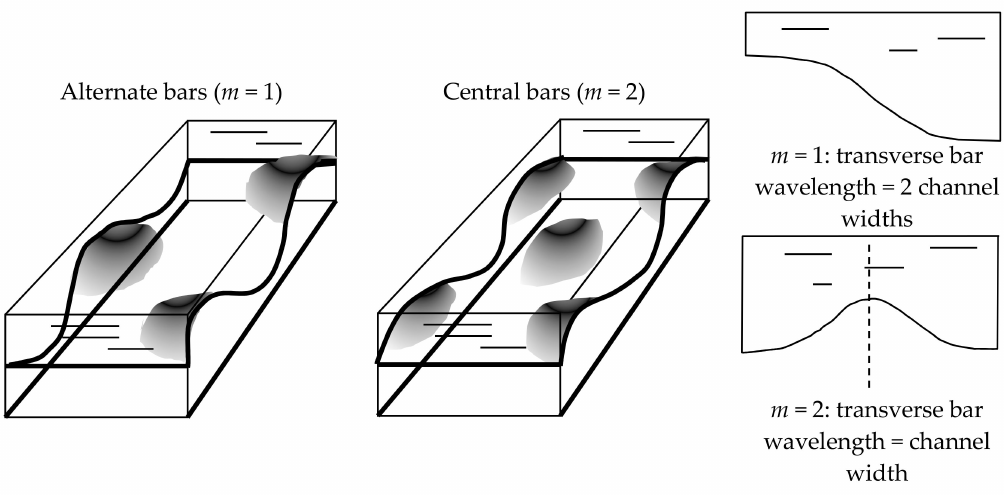
Figure 5. Longitudinal and transverse bed oscillations caused by the presence of alternate and central (periodic) bars. Alternate bars: one row of alternate bars in the channel ( m = 1). Central bars: two parallel rows of alternate bars in the channel ( m =